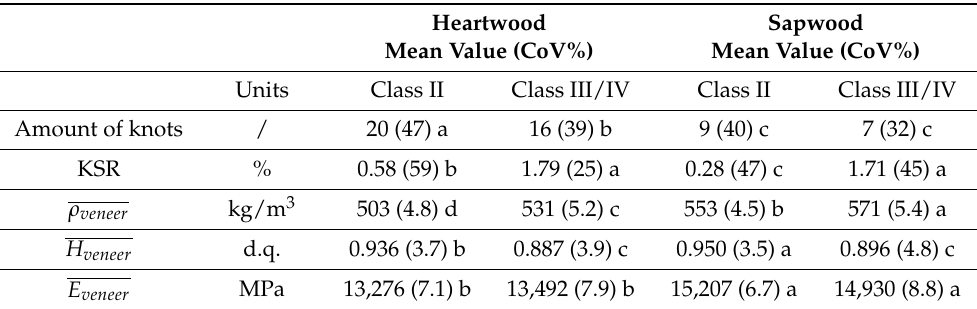
Table 4. Data from appearance classes.